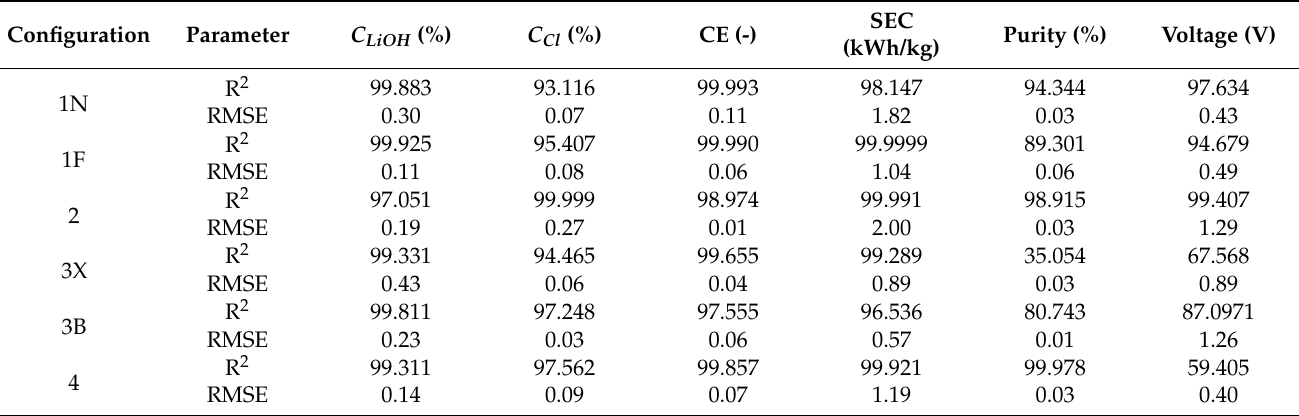
Table 4. R 2 coefficients determination and root-mean-square error between observed and predicted values as per mathematical